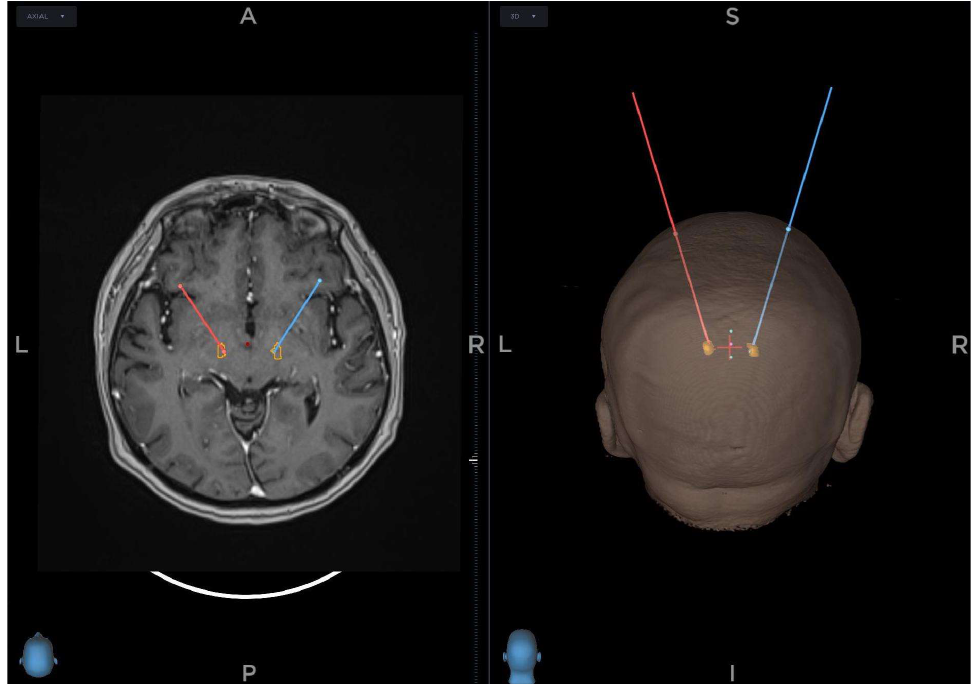
Figure 2. Planning trajectories and fusion of the images on the planning station (red line—trajectory on the left side, blue line—trajectory on the right side, A—anterior, P—posterior, R—right, L—left, S—superior, I—inferior, yellow—subthalamic